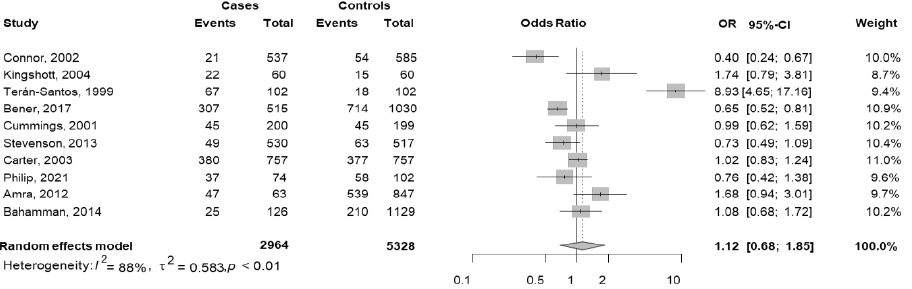
Figure 4. The forest plot of the subgroup meta-analysis of car accidents and non-car accidents with OSAS based on the questionnaire used [23,28,42,49,51,54,55,59 – 61]. Events Cases are defined as car accident with OSAS (total of 1000) and Total Cases as car accidents (2964); Events Controls are defined as non-car accidents with OSAS (total 2093) and Total Controls as non-car accidents (5328). In each group, a diamond represents the pooled OR estimate based on the random effects model.